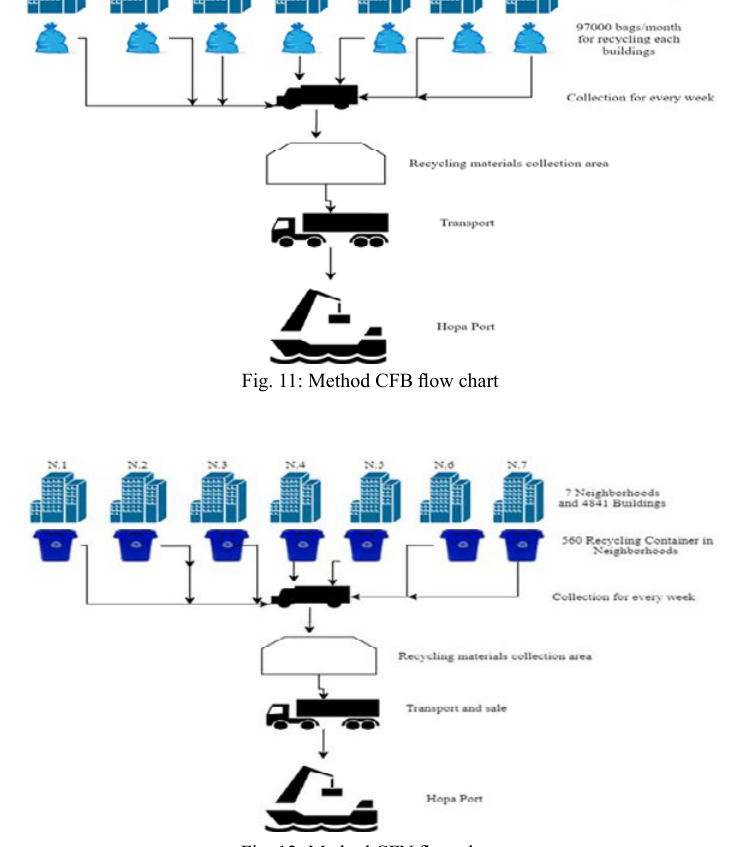
Fig. 12: Method CFN flow chart